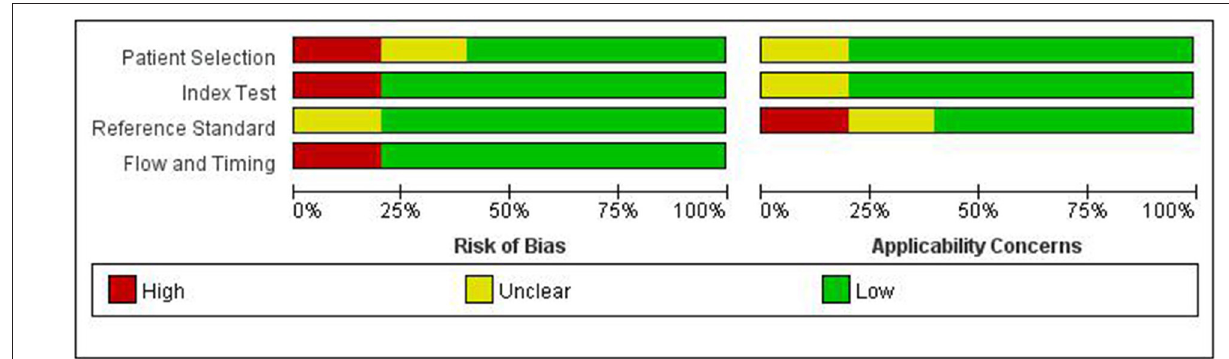
FIGURE 1 | Summary of risk of bias and applicability concerns.